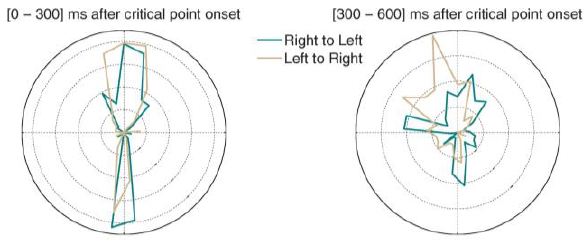
Figure 9 . Polar histograms for microsaccades after the critical point onset. Green indicates trials where the coin moved from right to left, and yellow those where the coin moved from left to right.